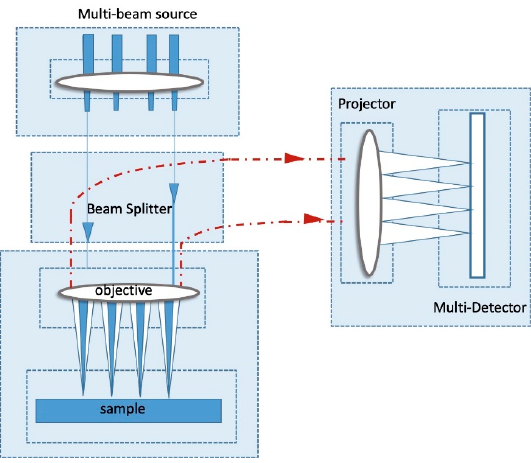
Figure 66. Schematic drawing of the multi-beam SEM.